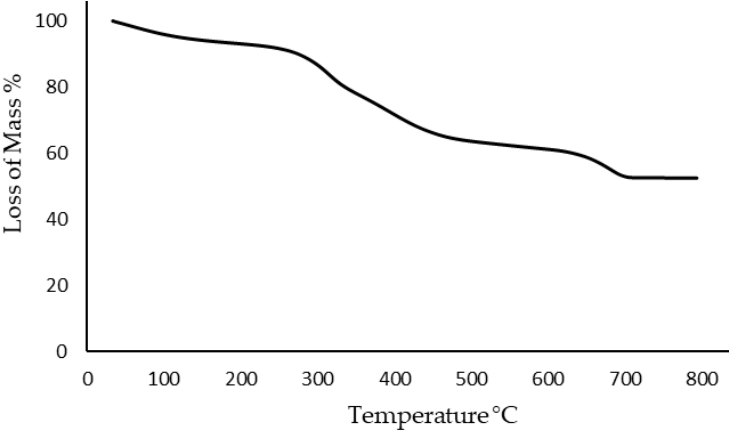
Figure 4. ATG curve of biochar synthesized by pyrolysis of a mixture of sludge and margins .